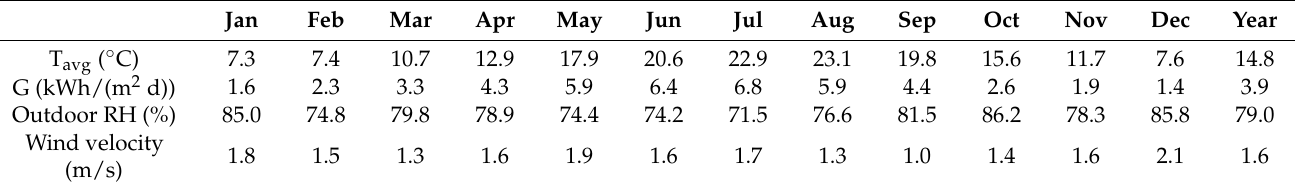
Table 2. Reference climatic data for